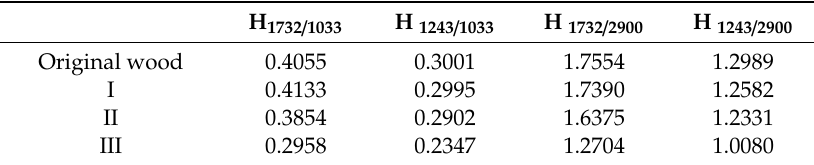
Table 2. Absorbance ratios H 1732 / 2900 and H 1243 / 2900 .